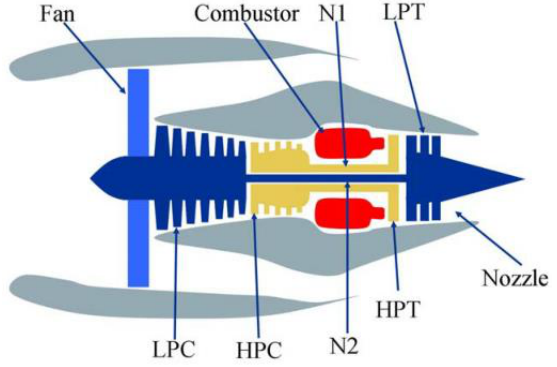
Figure 8. C-MAPSS turbofan engine diagram [34].